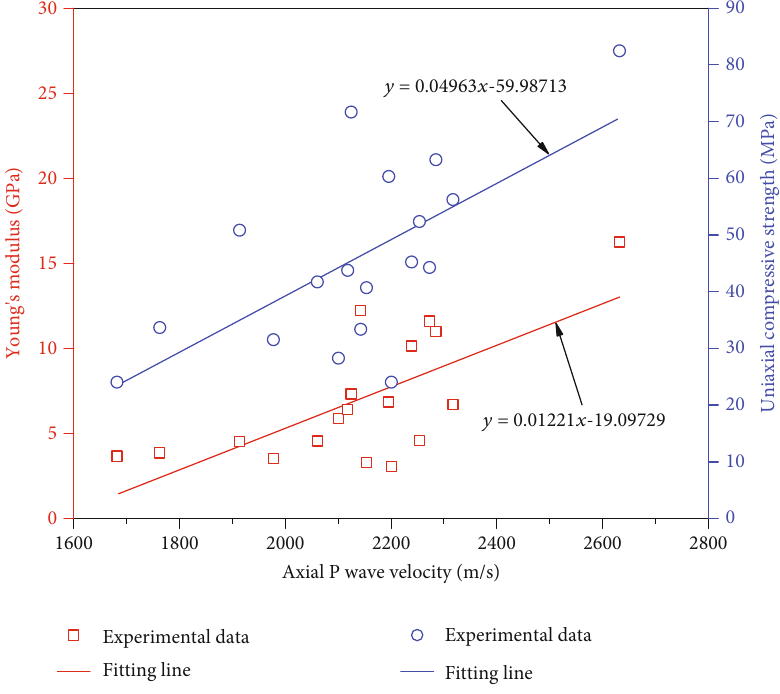
Figure 5: Correlation of uniaxial compressive strength, Young ’ s modulus, and axial P wave